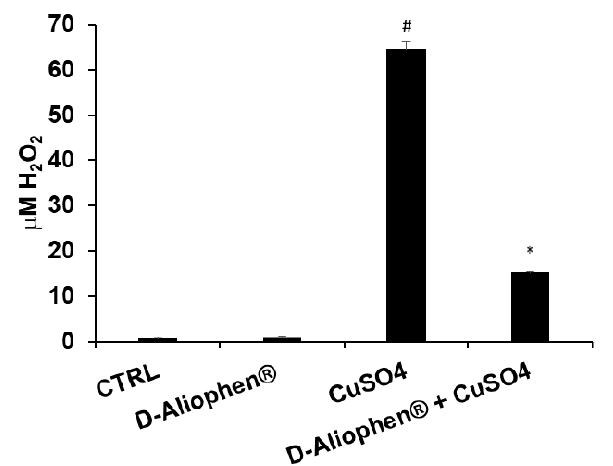
Figure 2. Protective effect of Aliophen ® against low-density lipoprotein (LDL) oxidation. LDL were incubated for 15 min in the presence of 0.25 mg/mL ( w / v ) of D-Aliophen ® , before the addition of 50 µM CuSO 4 . After the treatment FOX assay was performed to determine the level of peroxide (like H 2 O 2 ), produced following LDL oxidation. Bar graphs represent the mean ± SD. Symbols indicate significance: (#) p < 0.005 vs CTRL and (*) p < 0.005 vs CuSO4.